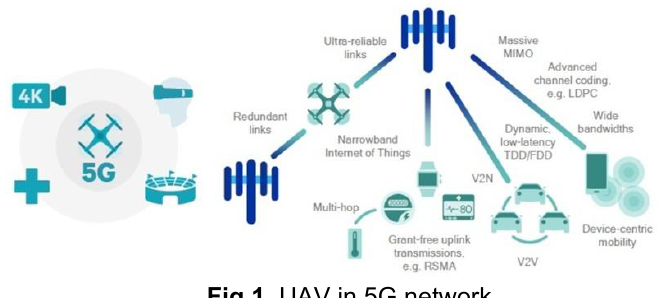
Fig 1. UAV in 5G network